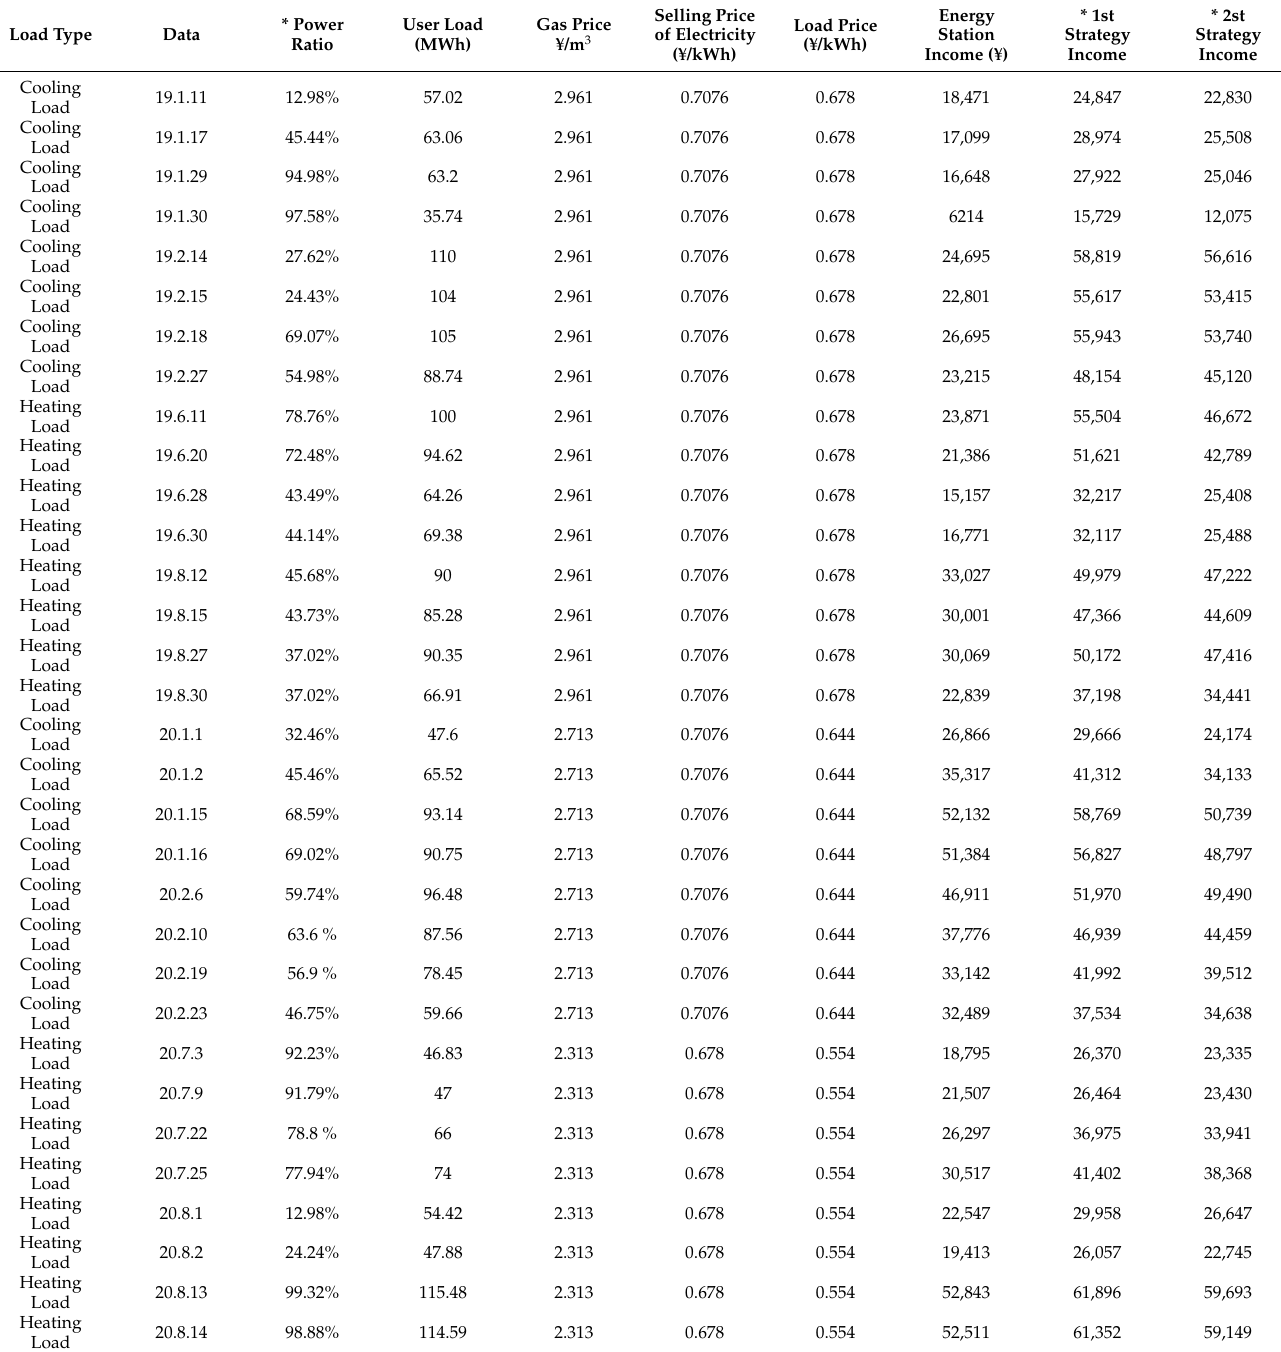
Table 4. Results of actual running and optimization algorithm